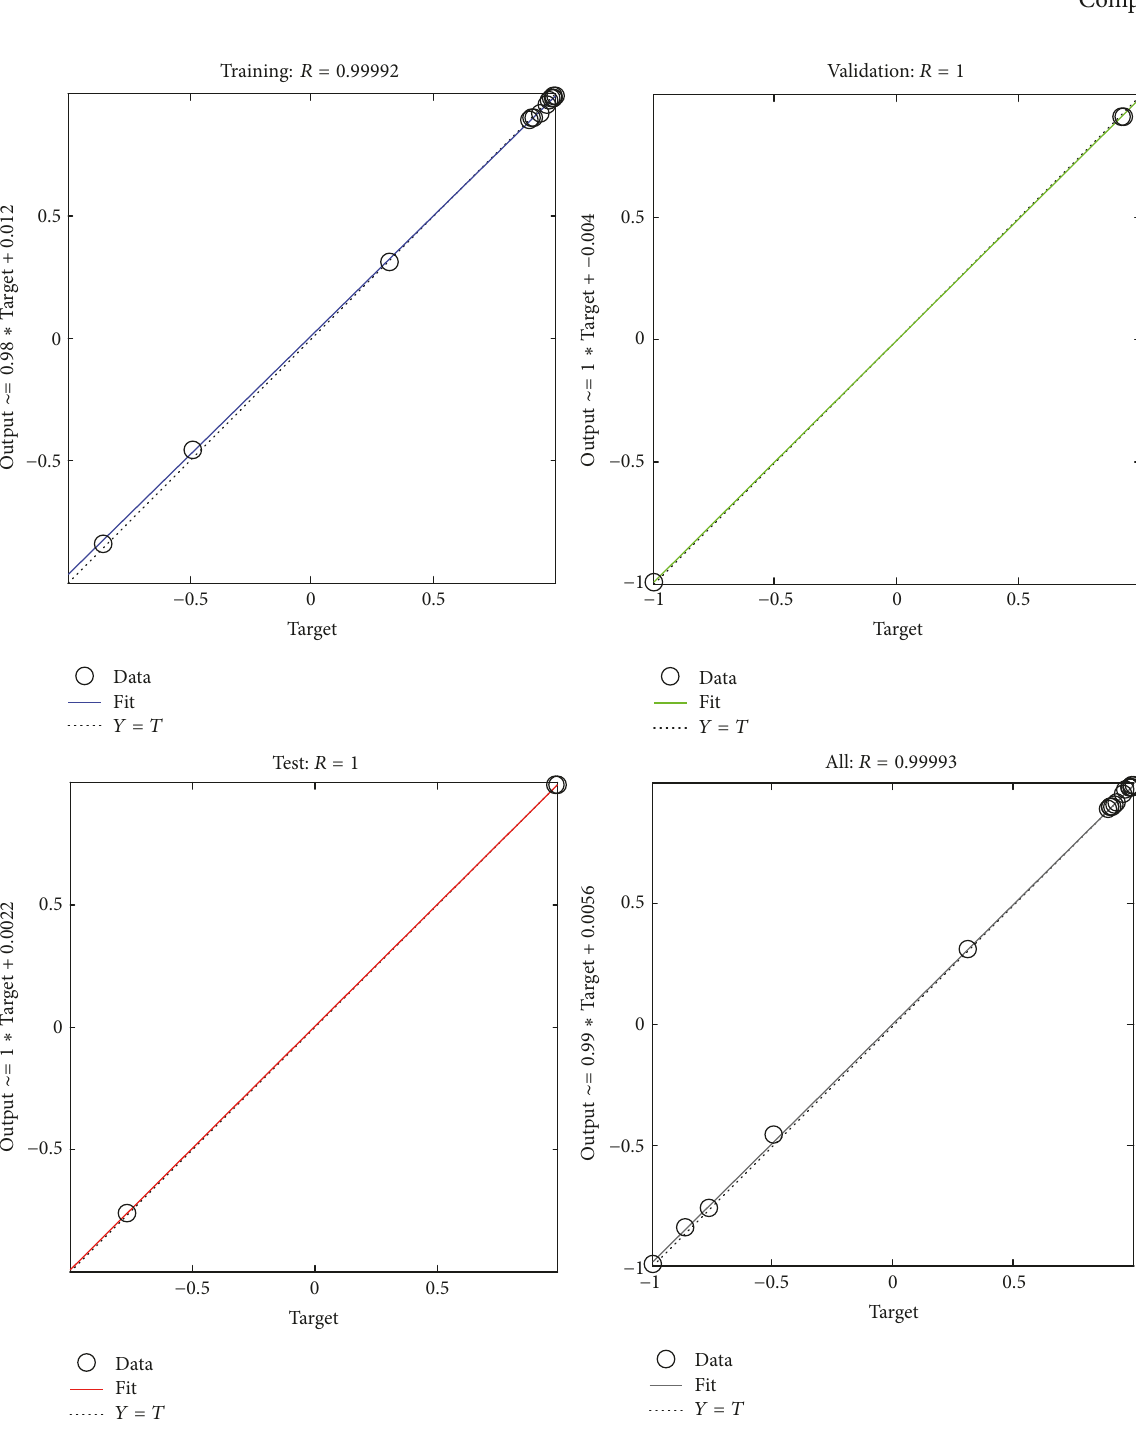
Figure 20: The regression analysis of the BP neural